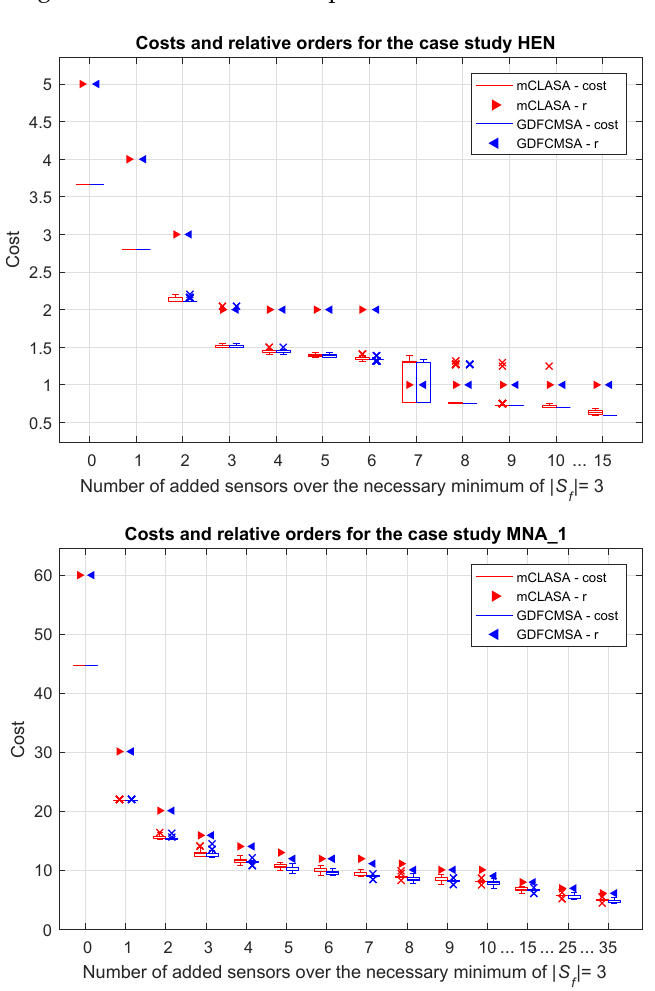
Figure 4. The values of the cost functions and relative degrees with regard to the number of added sensors in the case studies HEN and MNA_1. The box plots show the interquartile ranges and the medians of the cost functions, while the scatter plots visualize the minimum value of the relative order for 100 independent runs. For each value of the x -axis, the results provided by the mCLASA are shown on the left-hand side, and the results provided by the GDFCMSA algorithm are shown on the right-hand side. The triangles represent the relative orders, while the plus signs denote the outliers (if they exist) of the corresponding